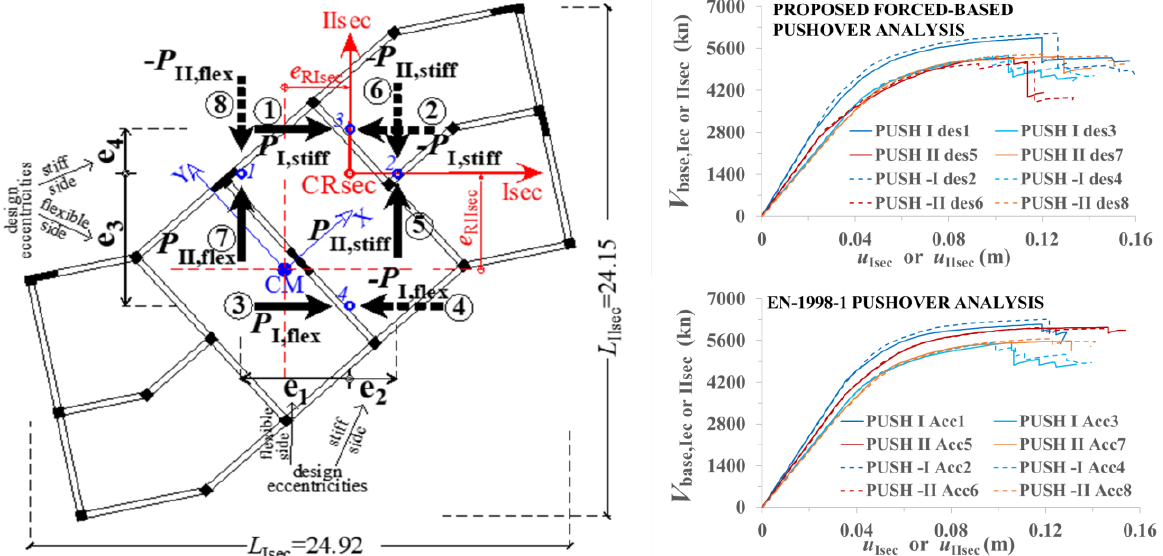
as the main principal direction, (right) 8 sec as the main principal direction.